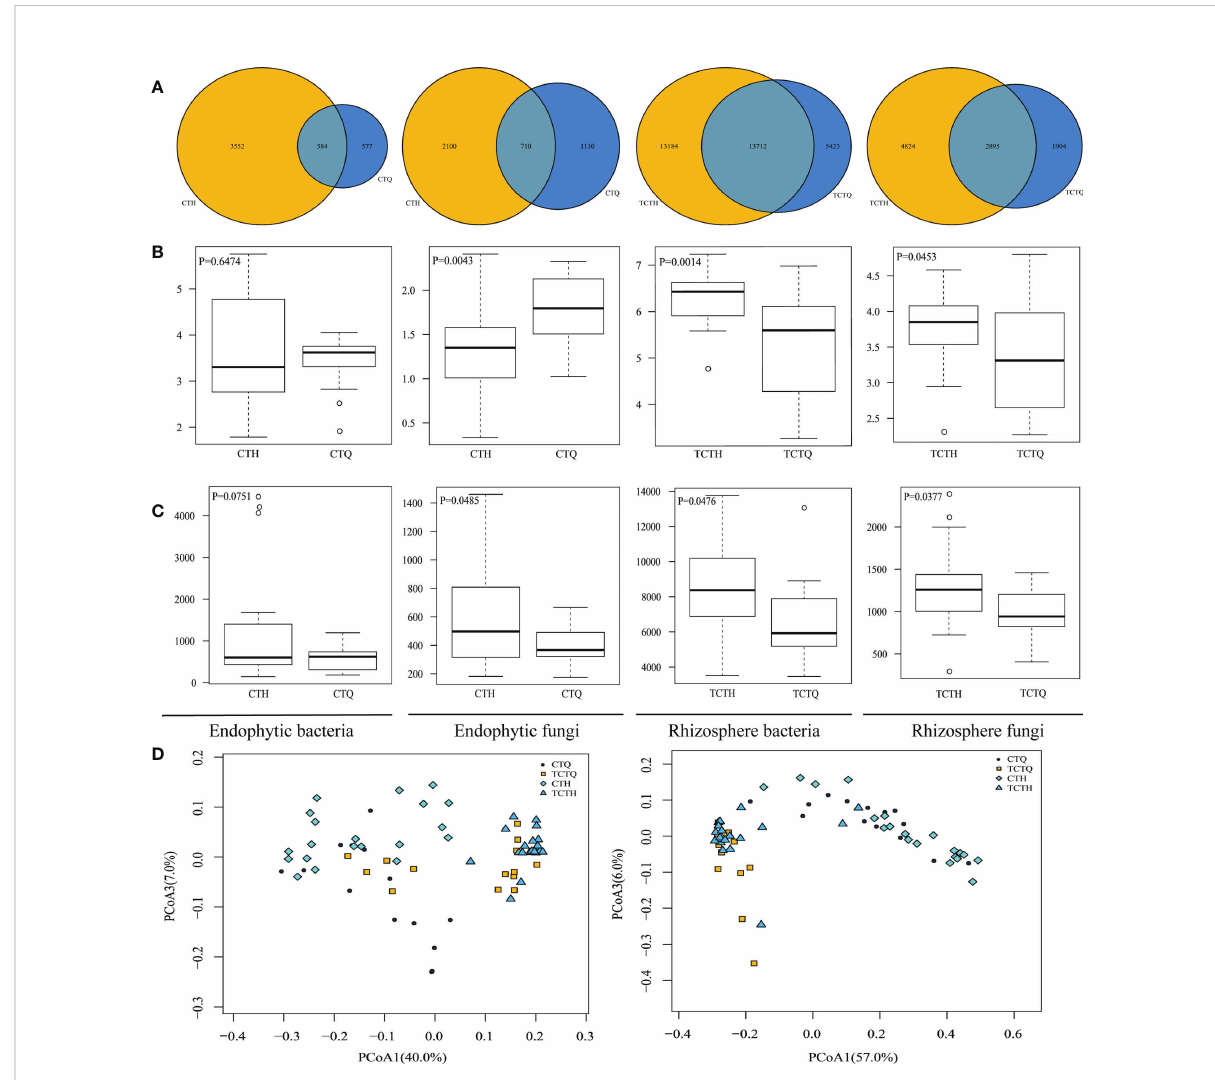
FIGURE 3 Differences of Qianhu in pre- and post-bolting periods. (A) Number of OTUs shared among different Qianhu samples. The number in the shaded overlap area indicated the total number of OTUs shared between sample types. (B) Sample diversity measurements of endophytic and rhizosphere samples. Species diversity was estimated according to the Shannon index. (C) Species community richness was estimated according to the ACE index. (D) PCoA analysis between roots and soil samples based on weighted unifrac distance. Bacteria can be found on the left and fungi on the